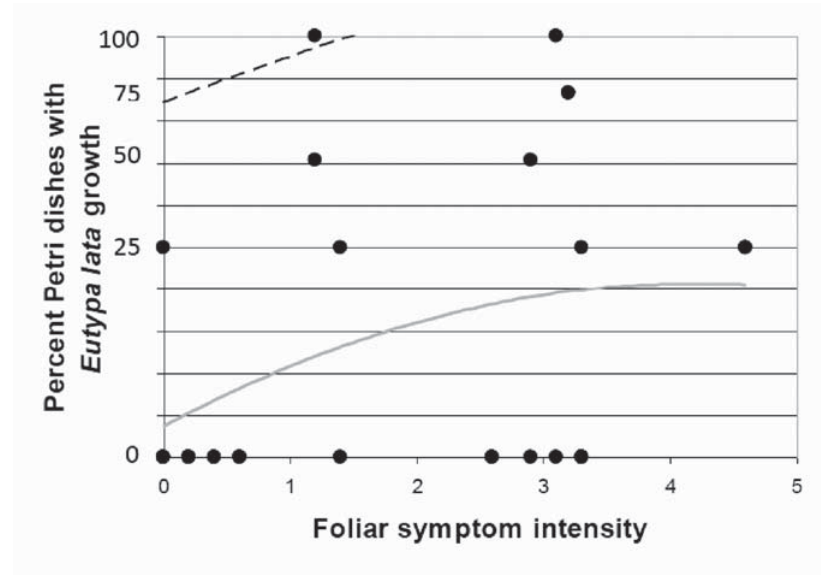
Fig. 2. Percent Petri dishes showing E. lata growth vs. foliar symptom intensity. Each dot represents at least one arm, and dots in the same vertical line represent the different arms from the same plant. The continuous line is the polynomial fi tted to square root data (proportion of Petri dishes) = 0.0722+0.1615 Symptom – 0.0191 Symptom 2 . The dotted line represents the 95% upper con fi dence limit.